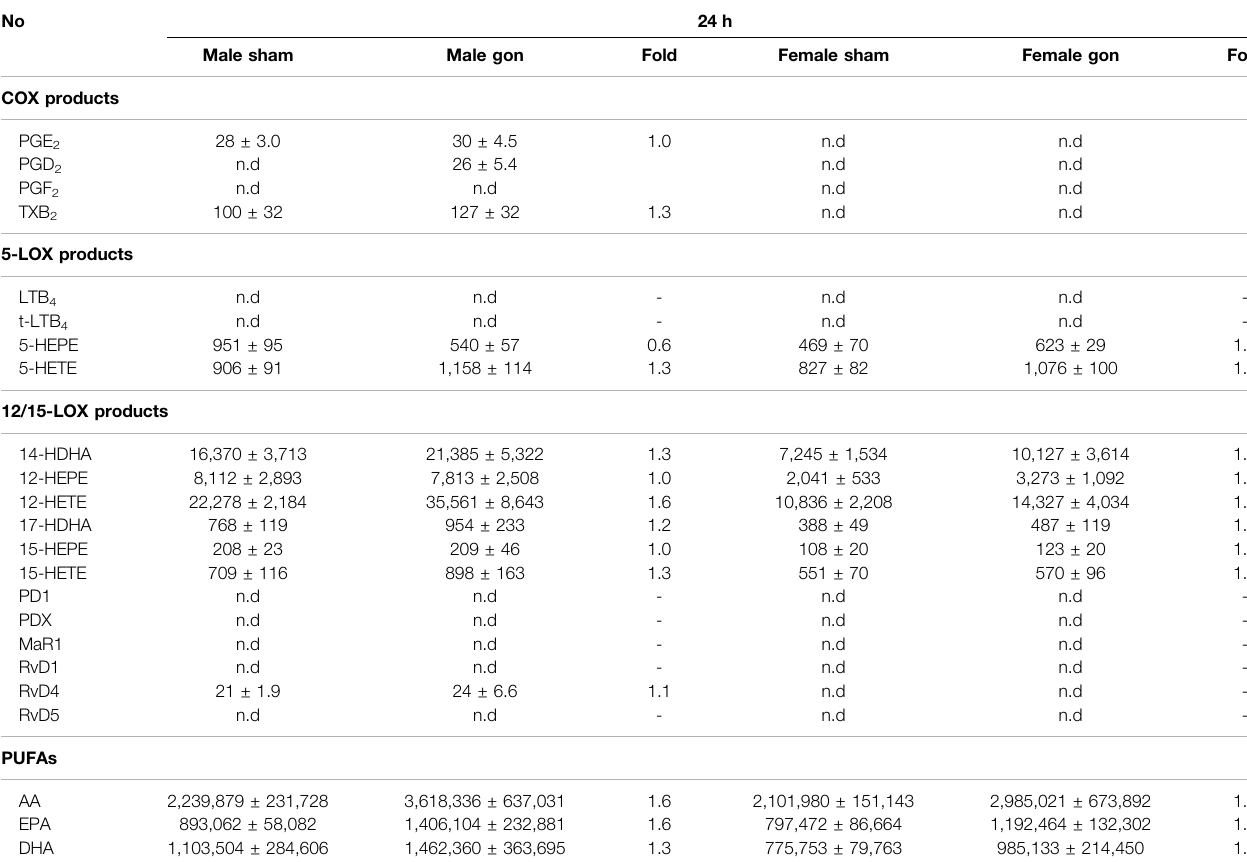
TABLE 5 | Effect of hormone depletion on lipid mediator pro fi les in plasma from male and female mice at 24 h post-zymosan injection. Amounts of LM in plasma from male and female mice 24 h post zymosan/vehicle i.p. injection that underwent gonadectomy or sham-operation. Data of n (cid:1) 5 to 6 animals per group are shown as mean ± SEM in pg/mL plasma and as heatmap. Fold-change of gonadectomy mean values compared to sham mean values of male and female